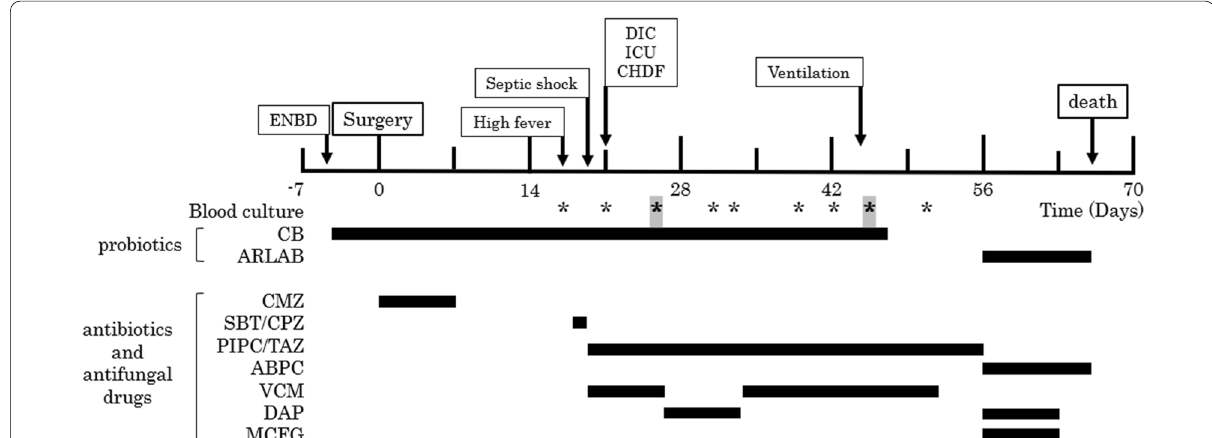
Fig. 2 Postoperative course of case 1. Asterisks indicate blood culture tests. Bold asterisks highlighted in gray indicate positive blood culture of Clostridium butyricum . ABPC, ampicillin; ARLAB, antibiotic-resistant lactic acid bacteria; C. butyricum , Clostridium butyricum ; CHDF, continuous hemodiafiltration; CMZ, cefmetazole; DAP, daptomycin; DIC, disseminated intravascular coagulation; EBD, endoscopic biliary drainage; ICU, intensive care unit; MCFG, micafungin; PIPC/TAZ, piperacillin/tazobactam; SBT/CPZ, sulbactam/cefoperazone; VCM, vancomycin